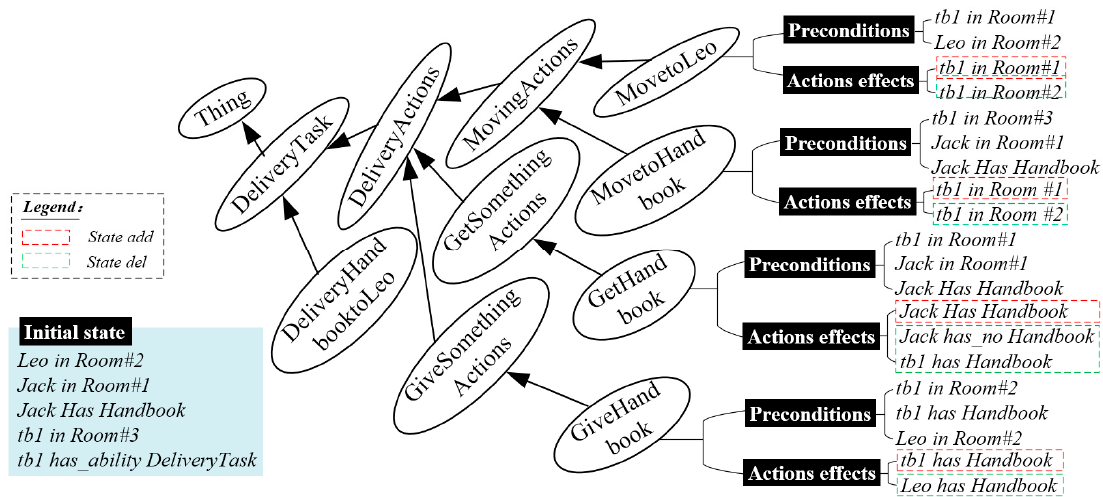
Figure 8. The representation method of atomic actions.